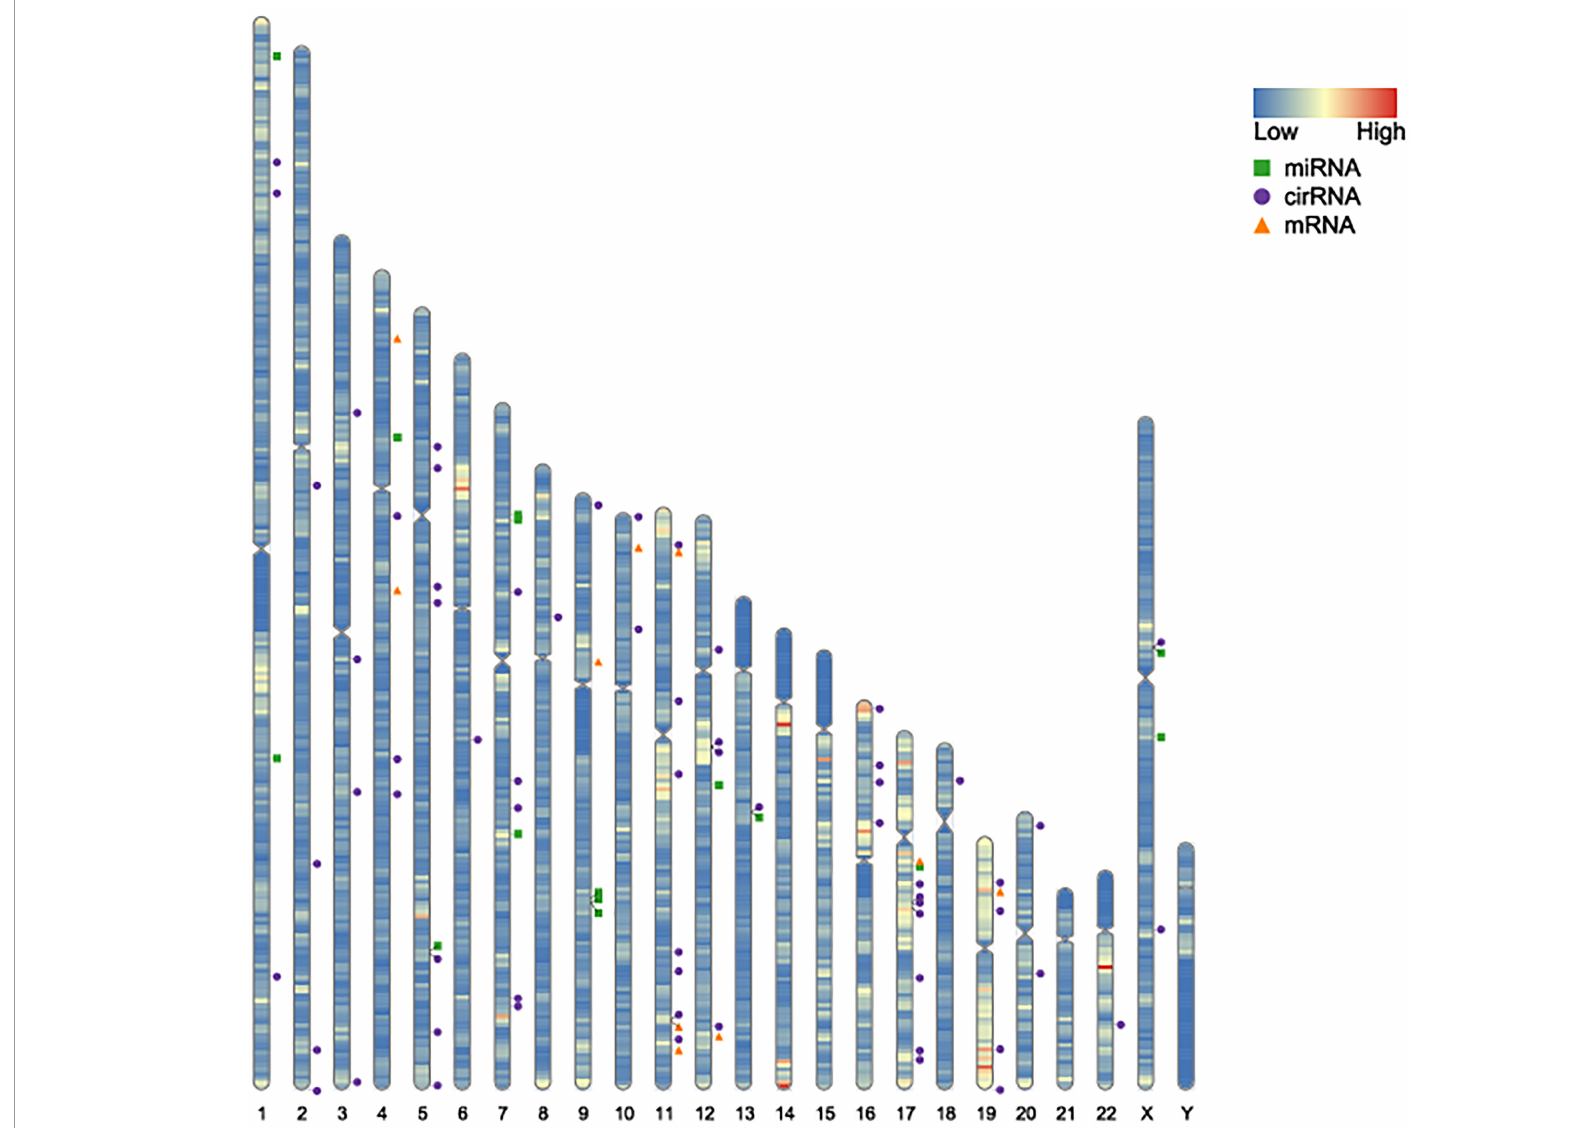
FIGURE 7 | Location on the chromosomes of DEGs, DEMs, and DECs. The orange triangle represents the chromosomal location of DEGs in GSE80178 and GSE143735. The green block represents the chromosomal location of DEMs in GSE68185 and GSE84971. The blue spot represents the chromosomal location of DECs in